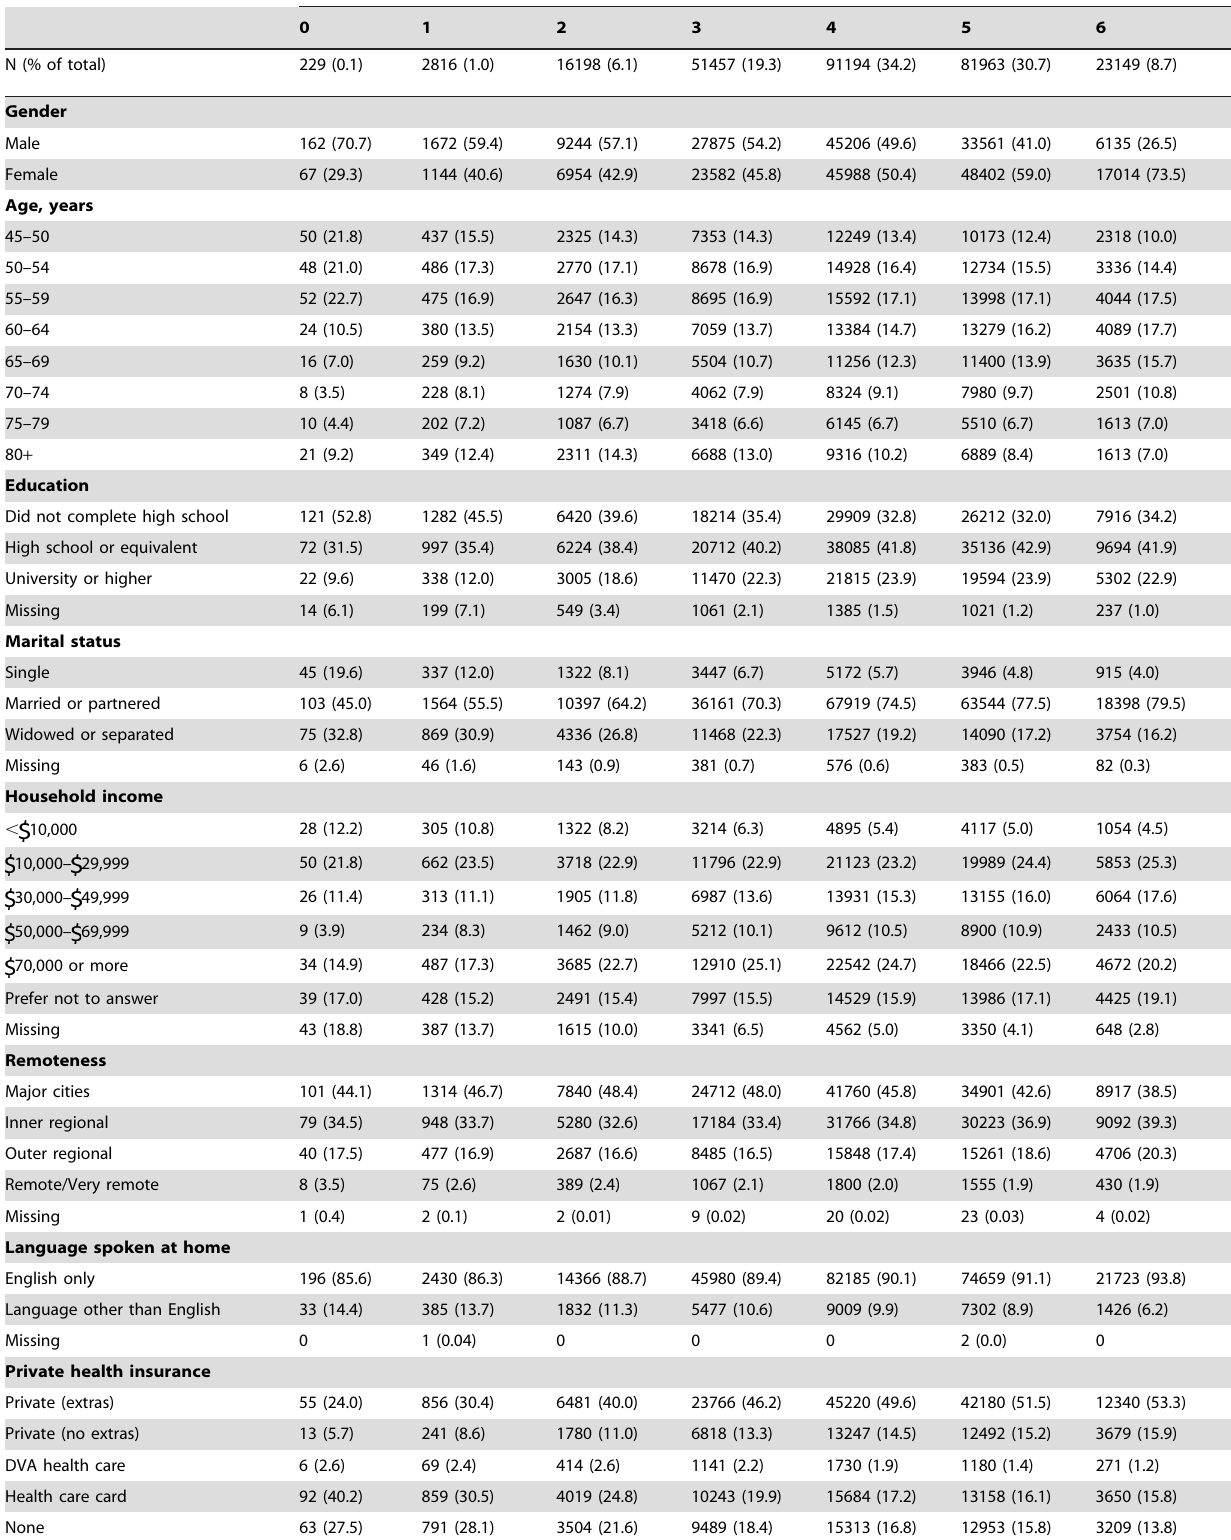
Table 1. Characteristics of participants according to number of positive health